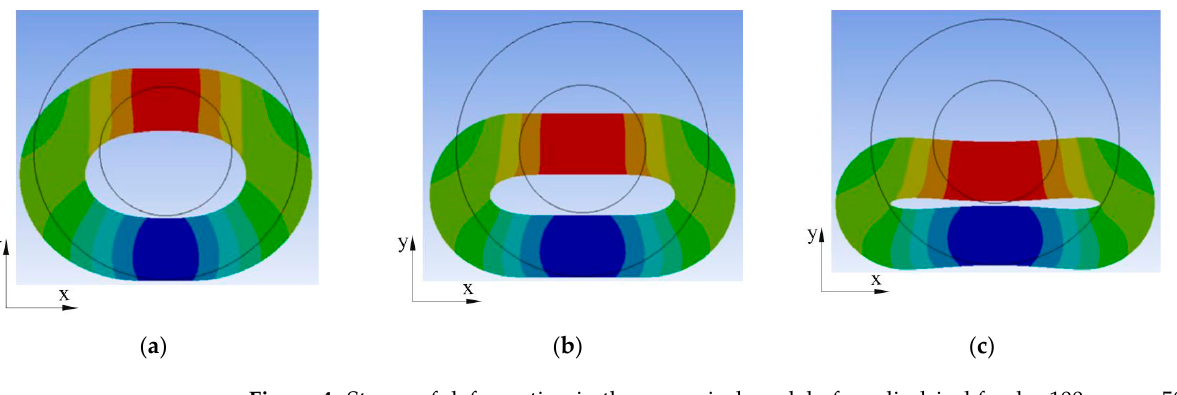
Figure 4. Stages of deformation in the numerical model of a cylindrical fender 100 mm × 50 mm × 500 mm until 50% deflection is achieved. ( a ) Stage 1, y = − 12.5 mm; ( b ) Stage 2, y = − 25.0 mm; ( c ) Stage 3, y = − 50.0 mm.